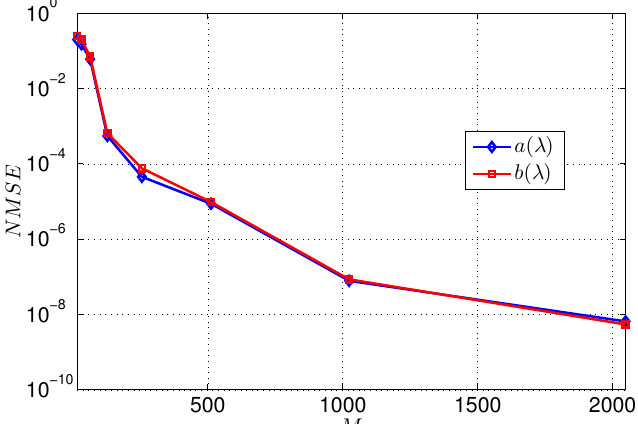
Figure 4. NMSEs of a ( λ ) and b ( λ ) for different values of M